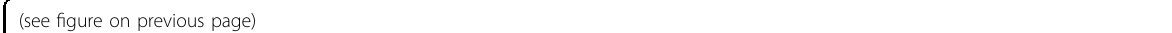
Fig. 1 Identi fi cation of miRNA-92a as the downstream effector of ER β in BCa. UMUC3 cells were transduced by lentivirus to overexpress ER β (oeER β ) or vector control (Crtl). J82 cells were transduced with lentiviral-shER β to knock down ER β , or -shLuc as control for the following experiments. a Cell lysates were collected from lentivirus-transduced J82 and UMUC3 cells. Western blot analysis was performed, and proteins were detected by antibody against ER β . b The MTT assay was used to analyze cell growth in J82 and UMUC3 cells transduced as described above to overexpress or knock down ER β . c The Matrigel invasion assays were performed in J82 and UMUC3 cells transduced as described above. d 3D invasion assay showed that more protruding structures formed in control J82 cells than in J82 shER β cells. e Real-time PCR screening of ER β -regulated miRNAs related to BCa progression. We compared the PCR pro fi le of miRNAs related to cancer cell growth and invasion in UMUC3 cells with overexpressed ER β vs. vector (Ctrl) and J82 cells with shER β vs. shLuc control (Ctrl). f Among the miRNAs screened, miR-92a and miR-129 expression were the most up-regulated by ER β . We transduced lentiviral-miR-92a and lentiviral miR-129 into BCa cells, and the results showed that the increased miR-92a, not miR-129, can selectively increase BCa invasion. g We used the TCGA database to analyze the BCa sample array with miR-92a expression, and the results showed that BCa tumors have higher miR-92a expression than normal bladder tissues. In c , d , and f , data are presented as the mean ± SD. * p <